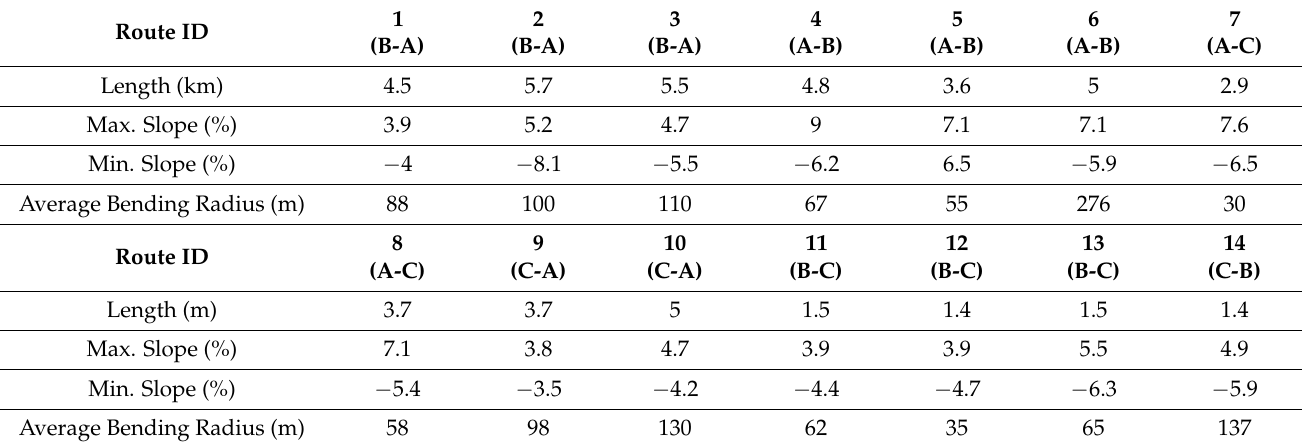
Table 2. Main data of the plano-altimetric profiles.